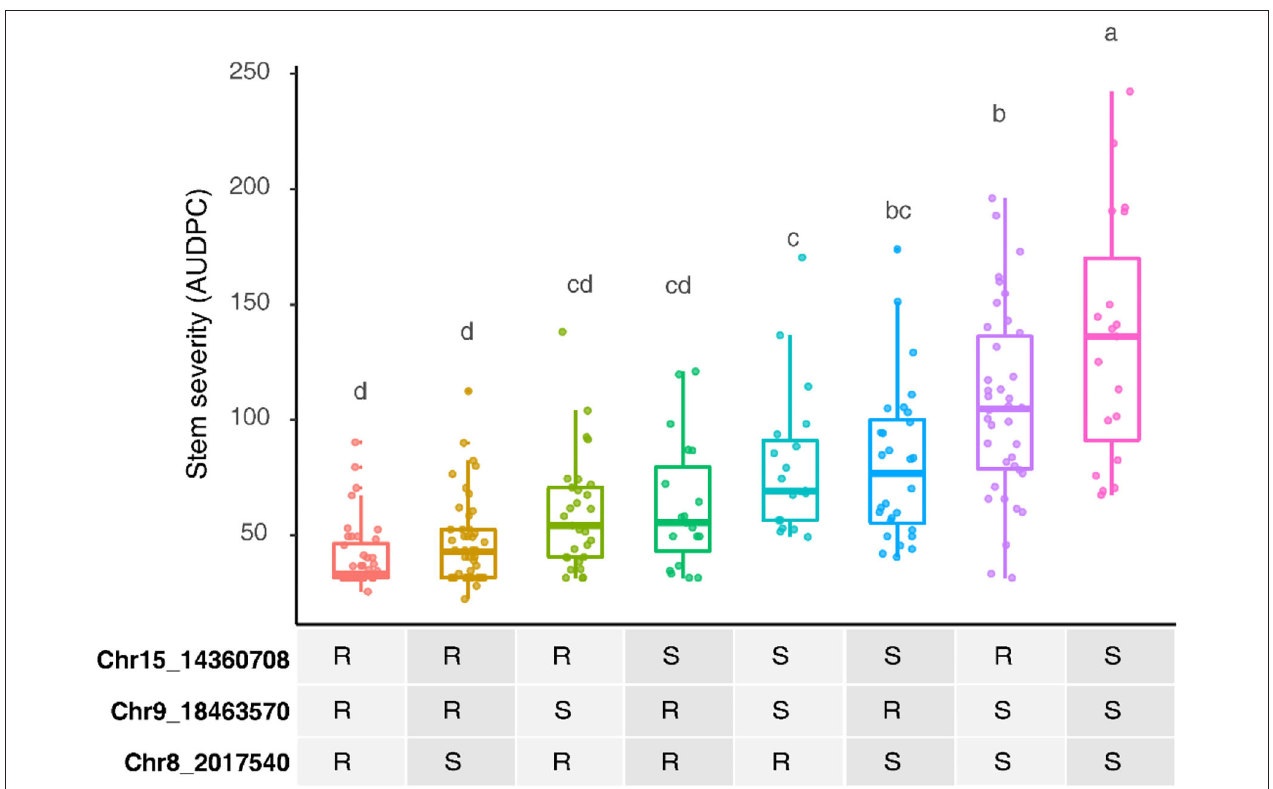
FIGURE 4 | Additive effects of the powdery mildew resistance alleles on stems in B37-28 × C56-11, assessed by area under disease progress curve (AUDPC) BLUEs for 2016 and 2017 combined. For the three peak markers, R, resistant haplotype and S, susceptible haplotype. Letters above each box indicate statistically significant differences detected by Fisher’s least significant difference test with Bonferroni corrections.